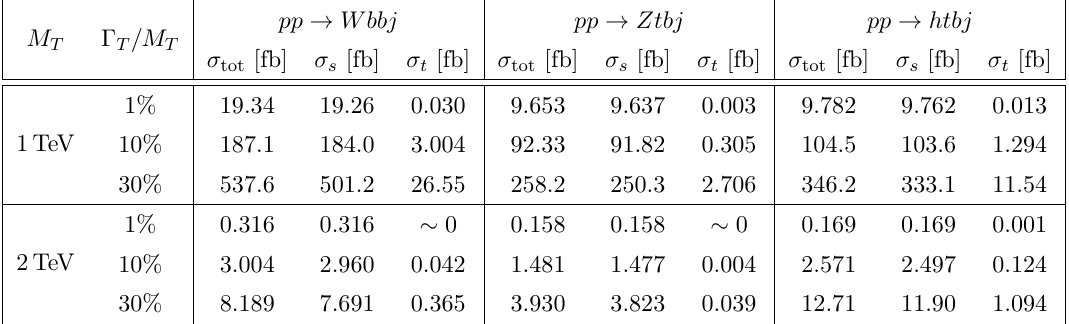
Table 1 . Total production cross sections for different vector-like quark masses and width-over-mass ratios in the complex mass scheme. The couplings are set to match the relation of eq. (3.5). We present results for proton-proton collisions at the LHC, at a centre-of-mass energy of 13 TeV and for the three processes of eqs. (3.1) and (3.2). For illustration purposes we separately show the individual resonant ( σ ) and non-resonant ( σ ) contributions, and the total physical rates ( σ s t which also include their